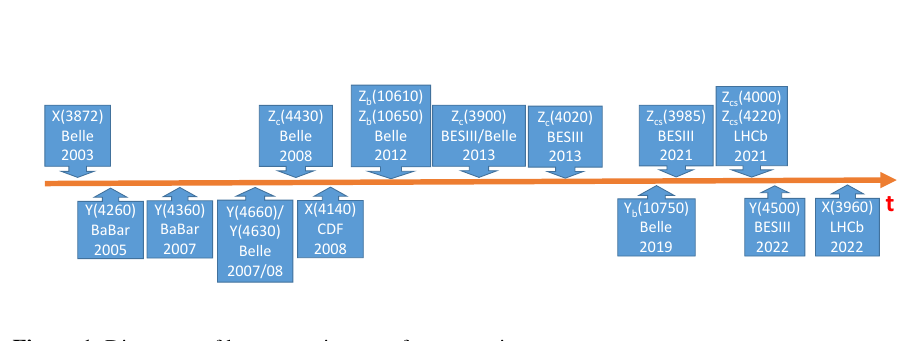
Figure 1. Discovery of heavy exotic states from